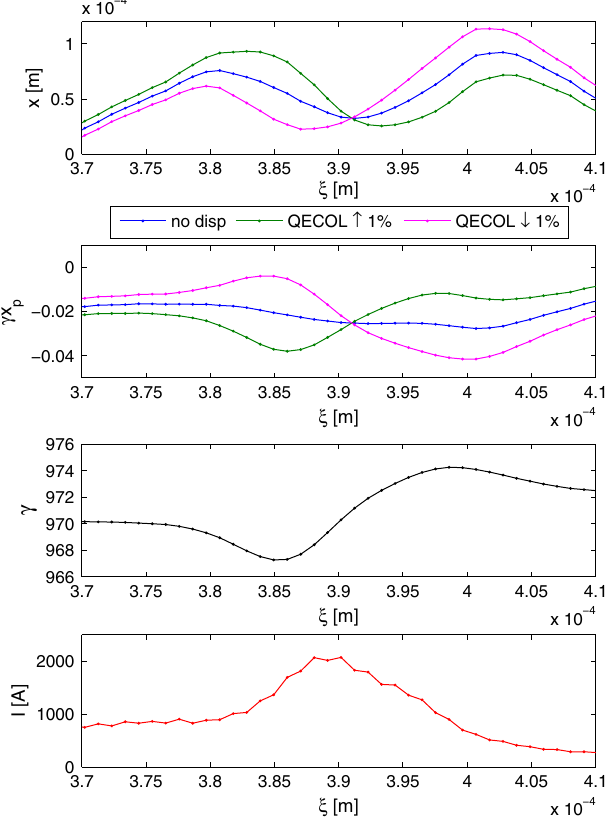
FIG. 16. (Color) Trajectory offset (first plot) and angle (second plot) along the longitudinal position of the bunch for the differ- ent dispersion conditions at the entrance of the undulator. The energy and current distribution are also plotted (third and fourth